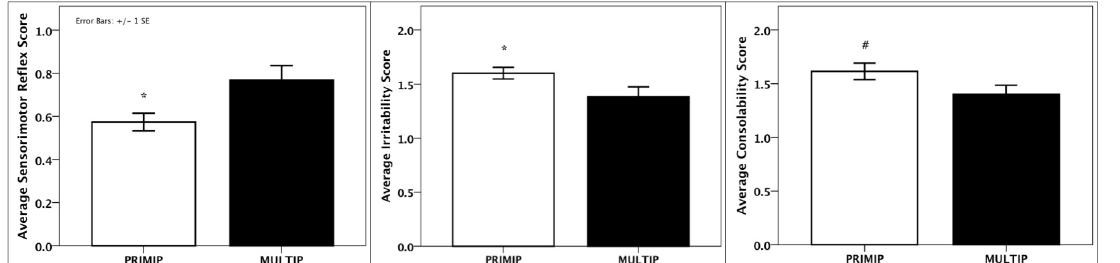
Fig 3. Parity differences in infant neurobehavioral development. PRIMP = primiparous, MULTIP = multiparous; * p < 0.05; #p < 0.10.